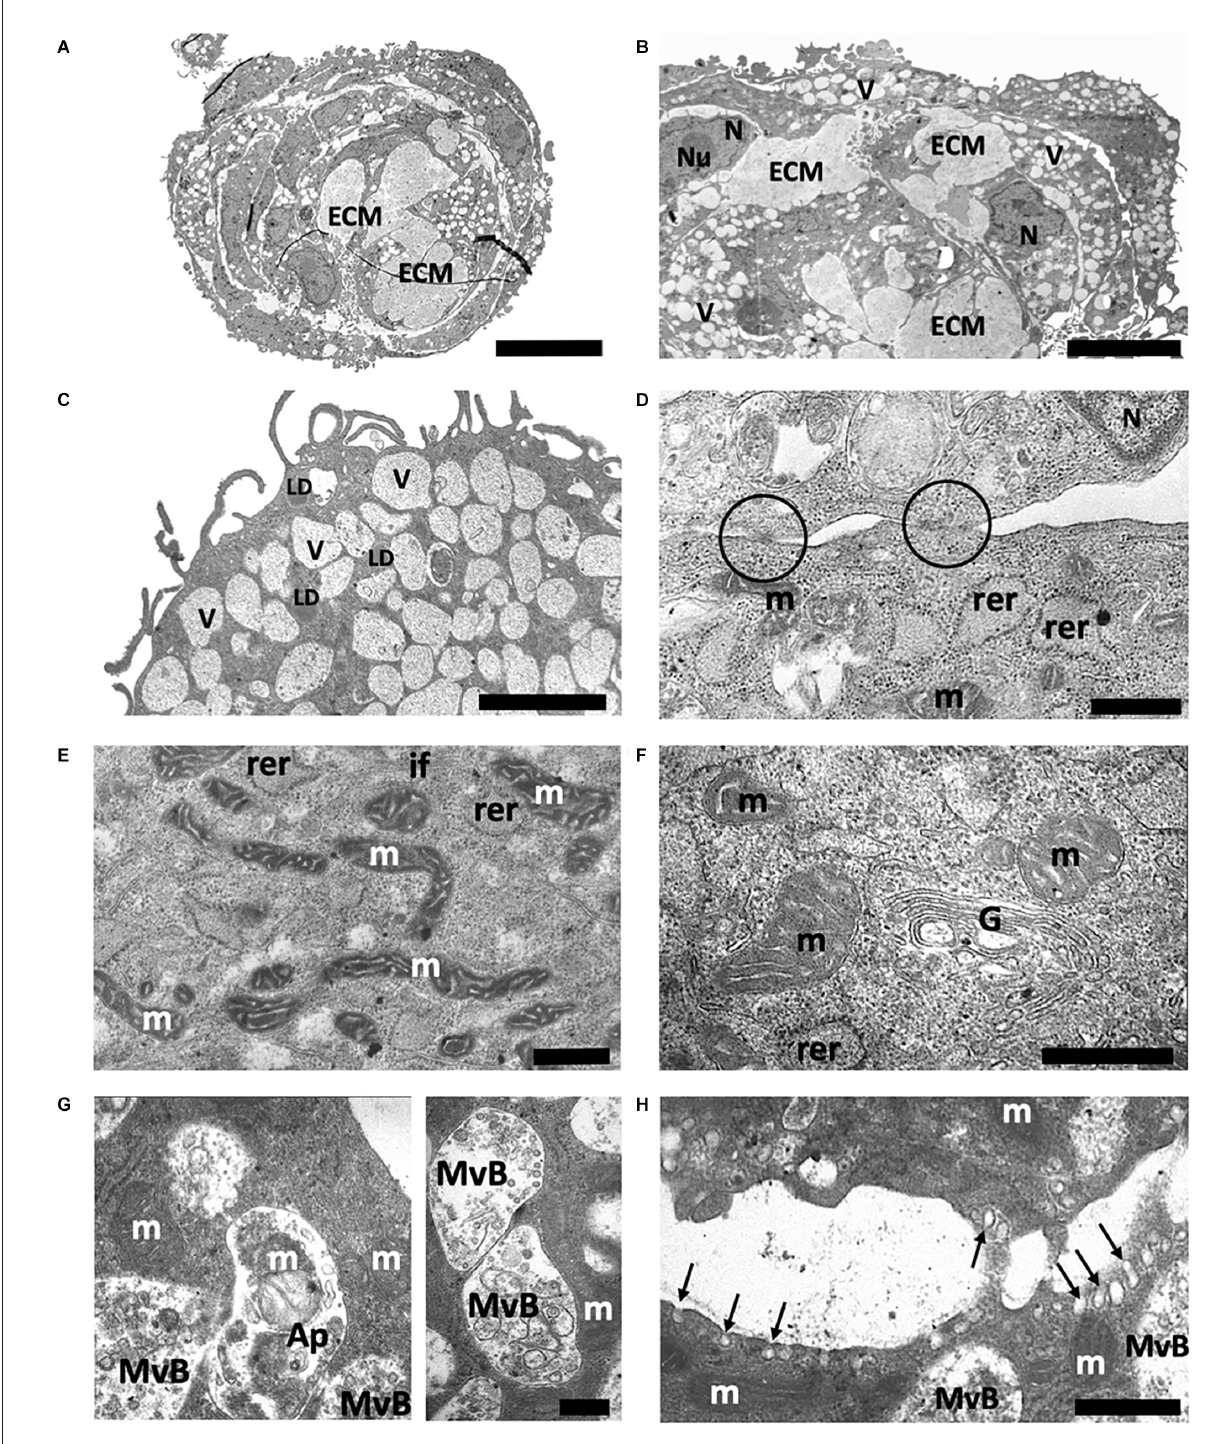
FIGURE3 Structure of spheroids from the adipose-derived multipotent mesenchymal stromal cells from young control CBA/Ca mice. (A) Central section giving an overview of representative ADSCs spheroid after 14 days of culture. Spheroid consists of the dense outer zone and the inner area, where round or polygonal cells are embedded in an extracellular matrix (ECM). (B) Elongated cells of the outer area and a part of the inner zone of ADSCs spheroids with an extracellular matrix. The ADSCs cytoplasm is extremely rich in vacuoles (V). N—nuclei; Nu—nucleolus. (C) In the outer area ADSCs has many thin pseudopodia extended from the cell surface. The ADSCs cytoplasm contains a large number of vacuoles and a moderate amount of lipid droplets (LD). (D) Plasma membranes of adjacent adipose-derived multipotent mesenchymal stromal cells are attached by numerous junctions, which appeared as tight junctions (circles). (E) Detailed view of cytoplasm containing a relative high amount of elongated electron-dense mitochondria (m), rough endoplasmic reticulum (rer), and intermediate filament (if) bundles. (F) Well-developed Golgi apparatus (G) producing large secreting granules. (G) ADSC cytoplasm containing a number of late endosomal multivesicular bodies (MvB). A fragment of mitochondria is observed inside the autophagosome (Ap). (H) The sites of active exocytosis (arrows) on the plasma membrane. Scale bars: (A) —25 µ m, (B) —15 µ m, (C) —2 µ